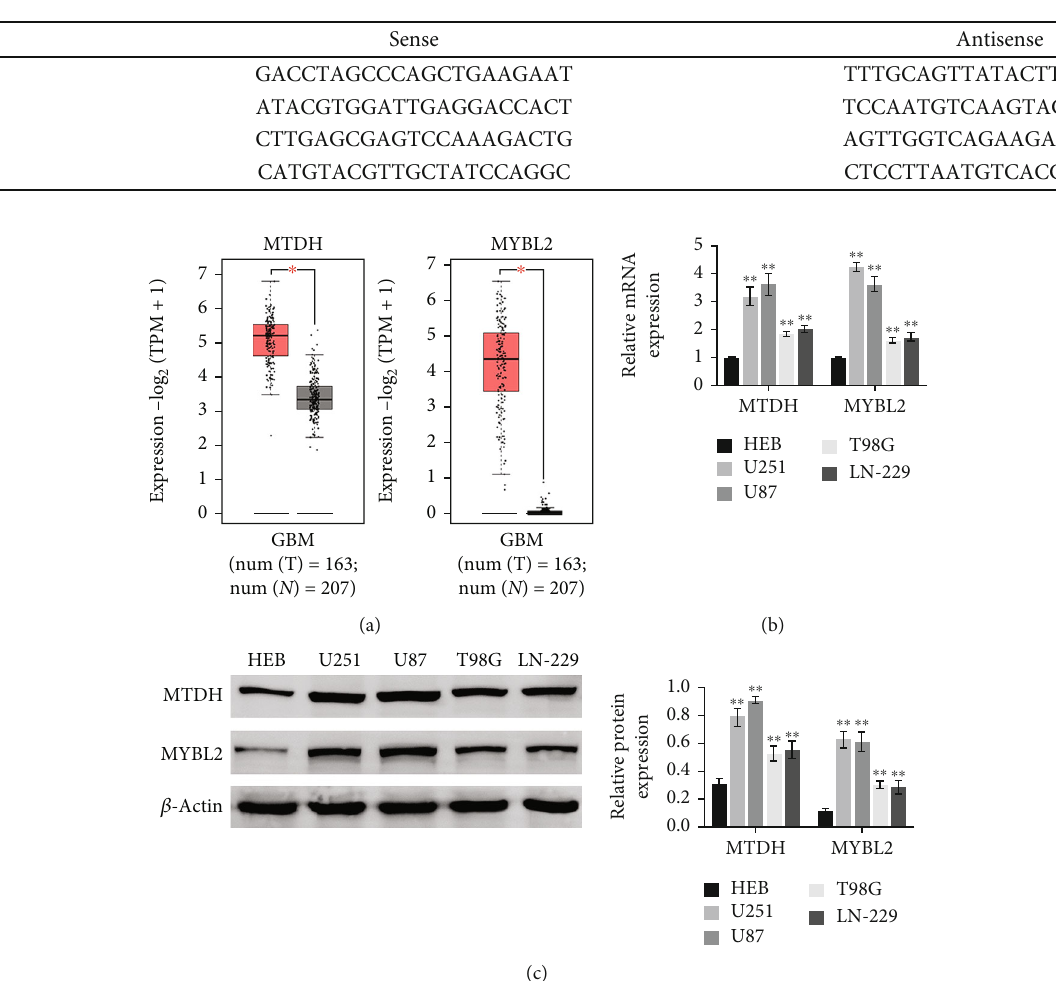
Figure 1: Di ff erential expression analysis of MTDH and MYBL2 in normal tissues and glioma cancer tissues (a). Di ff erential expression of two genes on the GEPIA online platform based on TCGA, the ordinate is the negative logarithmic transformation value of TPM+1 (b). In HEB, U251, U87, T98G, and LN-229 fi ve cell lines. The relative expression levels of two genes in HEB, U251, U87, T98G, and LN-229 cell lines. N = 3 , ∗∗ p < 0 : 01 vs. the HEB